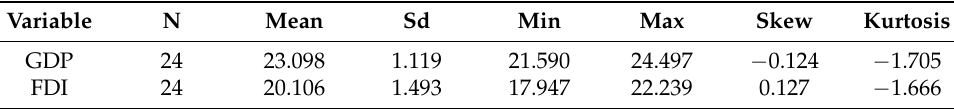
Table 3. Descriptive statistics of variables.